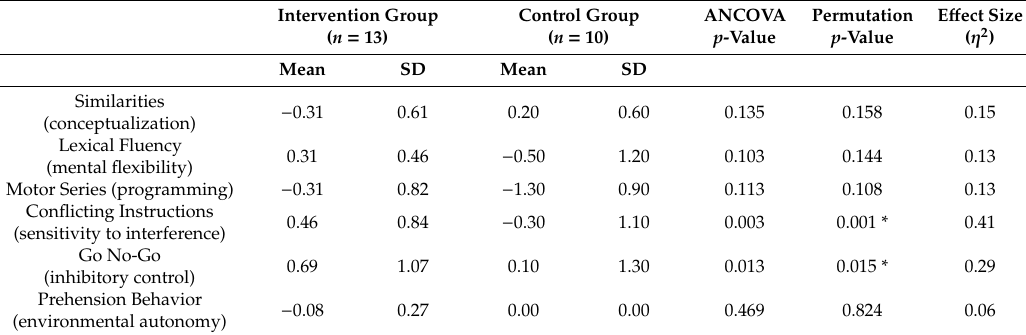
Table 4. Comparison of score changes for FAB subscores after